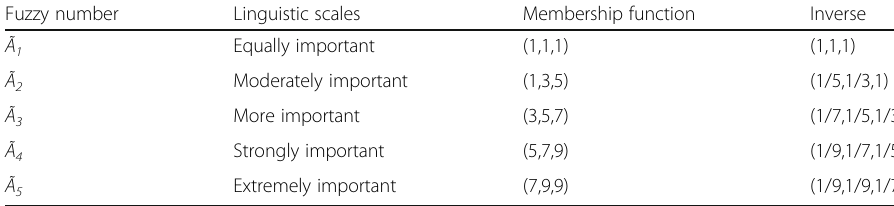
Table 3 The linguistic comparison terms and their equivalent fuzzy numbers Fuzzy